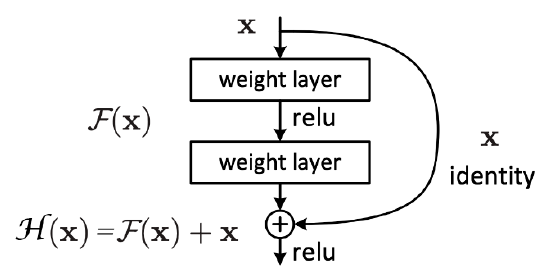
Figure 6. Schematic diagram of shortcut connection [27].